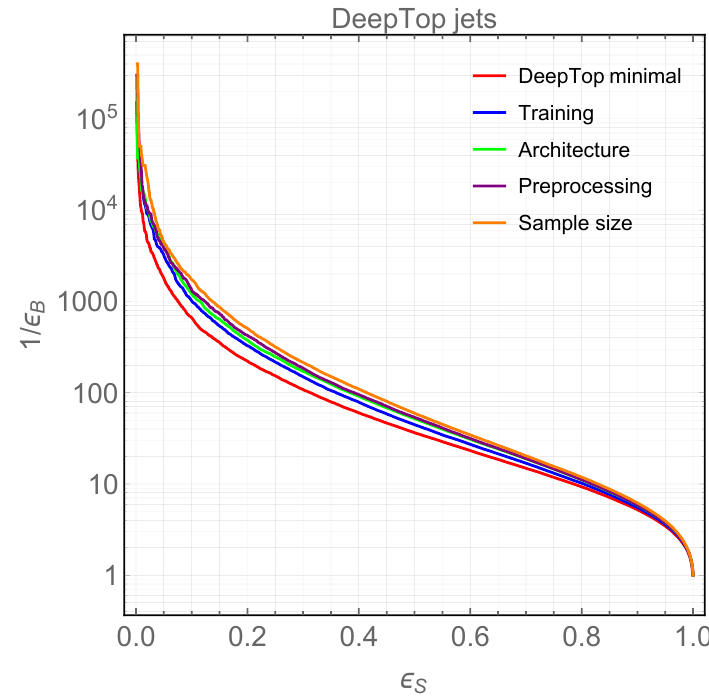
Figure 4 . Sequence of ROC curves (background rejection 1 =(cid:15) B vs. tagging e(cid:14)ciency (cid:15) S ) illustrating the cumulative e(cid:11)ects of the various improvements to the DeepTop tagger, for the DeepTop jet sample. Our (cid:12)nal tagger including all the improvements is shown in